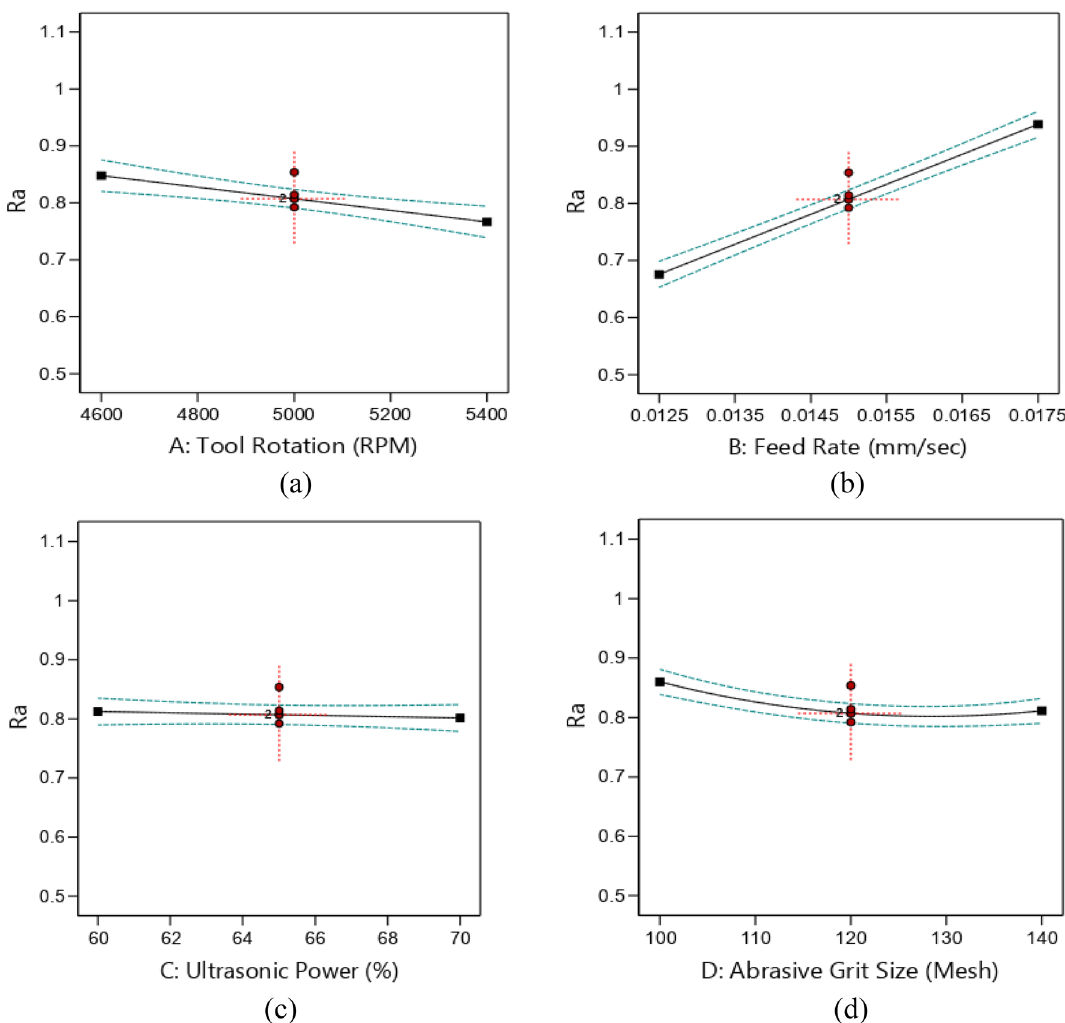
Figure 11. Effects of RUM parameters on R a ( a ) tool rotational speed, ( b ) feed rate, ( c ) ultrasonic power, ( d ) abrasive grit